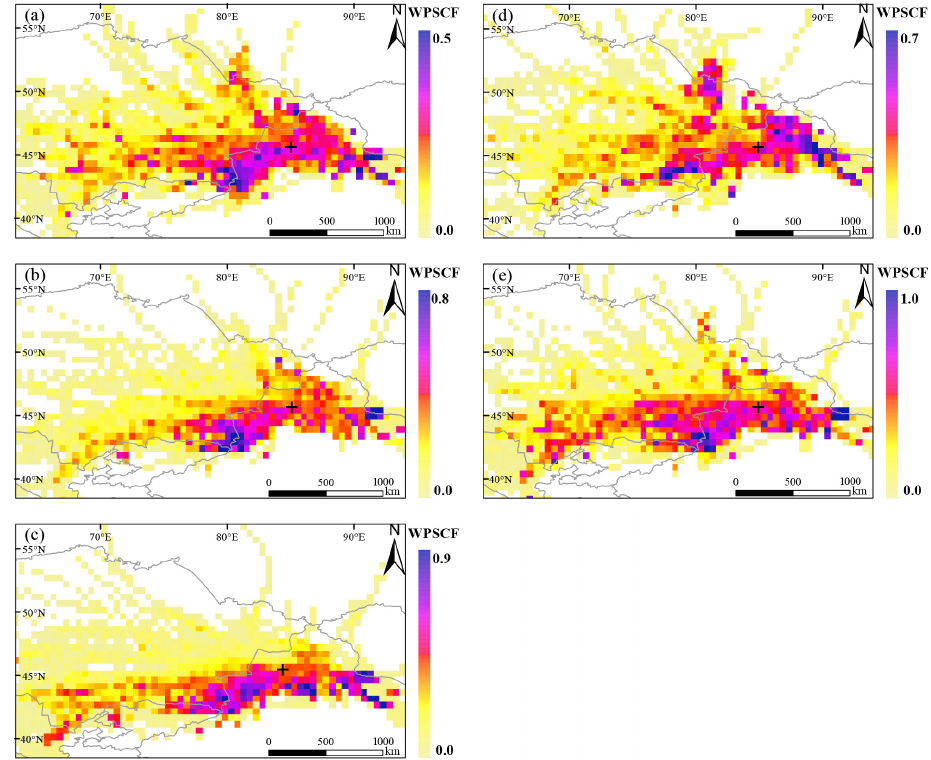
Figure 15. Annual weight potential source contribution function (WPSCF) maps for five identified sources derived from PMF analysis including oil refineries (a) , NG (b) , combustion (c) , asphalt (d) and fuel evaporation (e ). The black cross represents the sampling